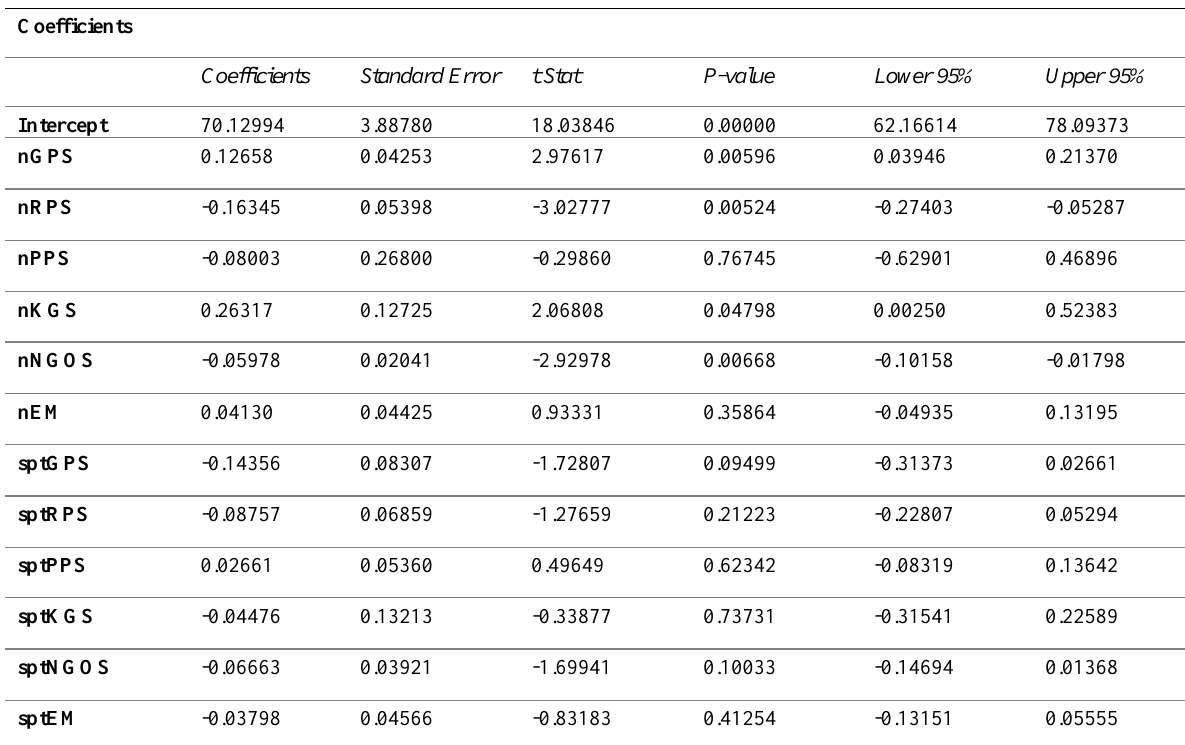
Table 6: Coefficients (Barisal